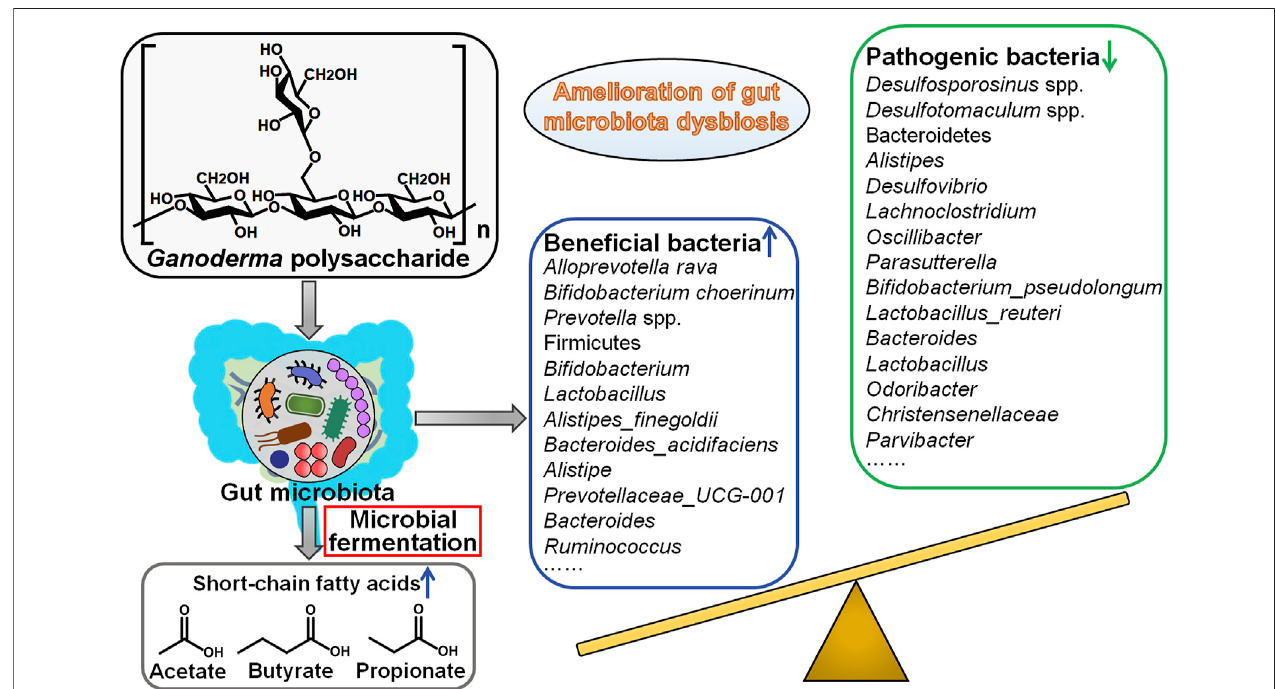
FIGURE 3 | Mechanistic implications ofintestinal microbiota in Ganoderma polysaccharides ’ protective effects against cancer. Gut microbiota dysbiosis has been associatedwithcarcinogenesisandcancerdevelopment. Ganoderma polysaccharidescanaffectgutmicrobiotacomposition.Particularly, Ganoderma polysaccharides enrich bene fi cial commensal microorganisms (e.g., Alloprevotella rava , Bi fi dobacterium choerinum and Prevotella spp.) while diminish the quantity of pathogenic microbial species (e.g., Desulfosporosinus spp., Desulfotomaculum spp. and Bacteroidetes), thereby leading to the amelioration of gut microbiota dysbiosis and tumor inhibition. Furthermore, Ganoderma polysaccharides increase the abundance of short-chain fatty acid (SCFA) producers and enhance the generation of SCFAs, which have been found to possess anticancerous activities.